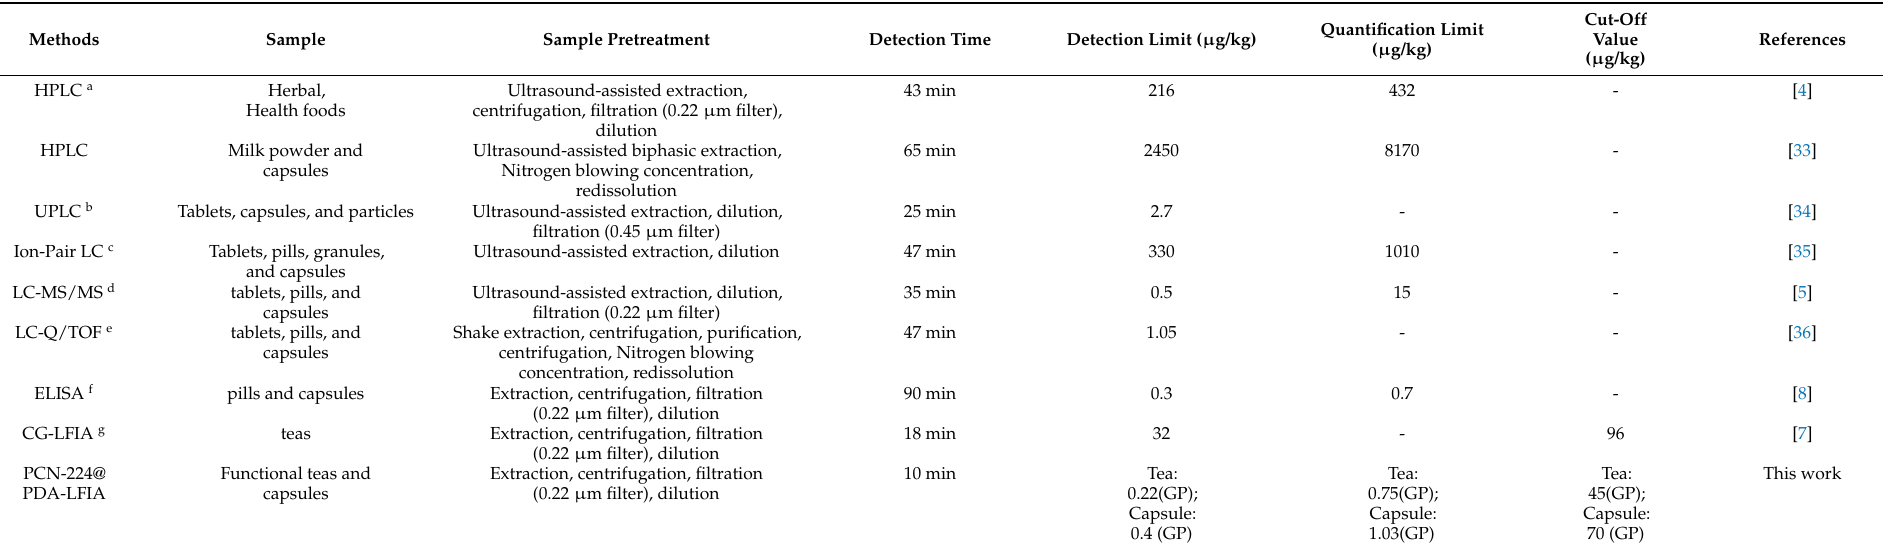
Table 2. Performance comparison of the developed PCN-224@PDA-LFIA with other methods for SUs